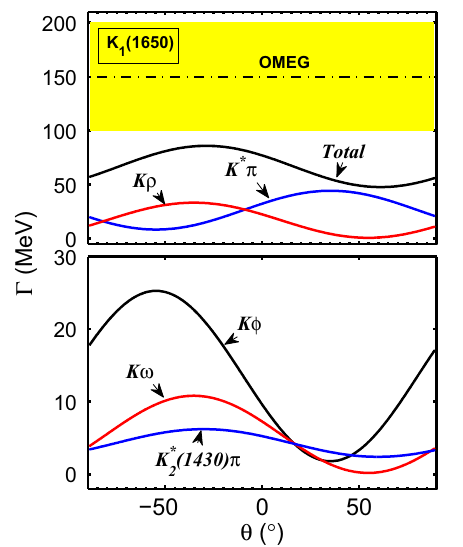
Fig. 5 θ 2 P dependence of the decay widths of K 1 ( 1650 ) as a 2 P state with the measured center mass of 1793 MeV from LHCb [66], where the dot-dashed line is the experimental value of LHCb